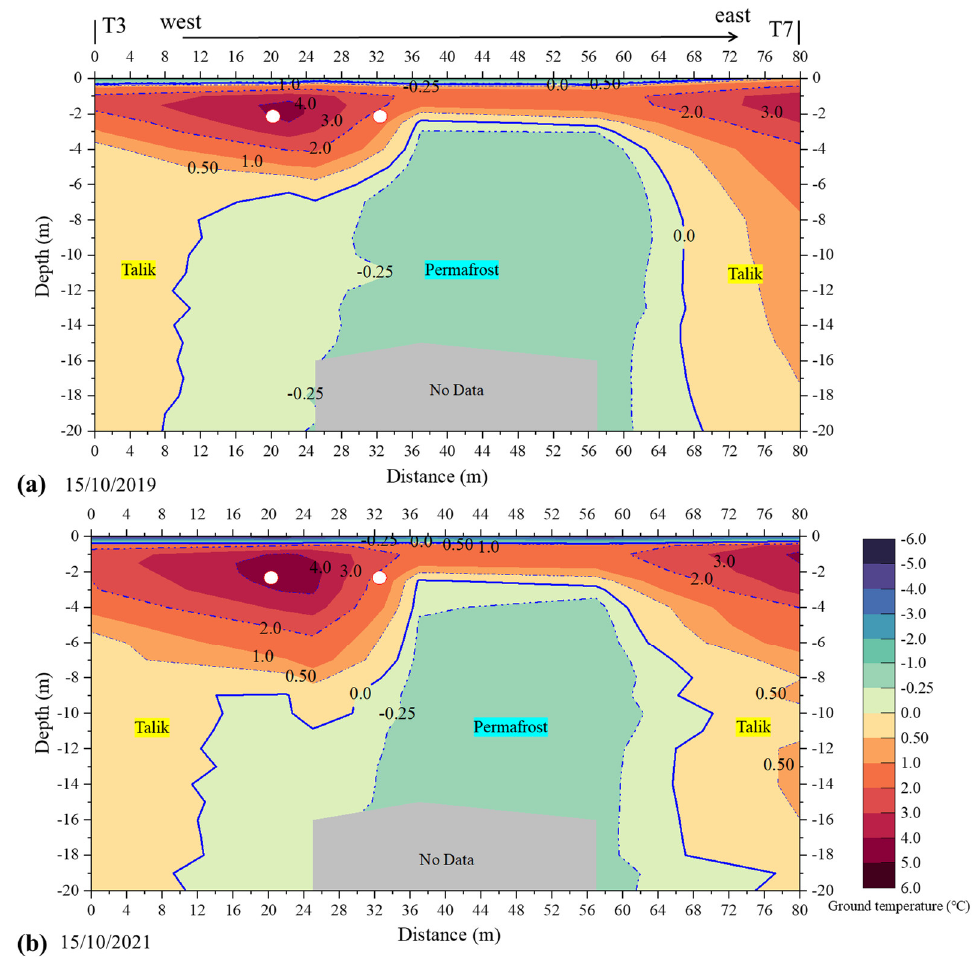
Figure 13. The cross-sectional isotherm profiles of the MDS304 site on 15 October 2019 ( a ) and 15 October 2021 ( b ) were drawn by using the inverse distance weighting method. Note: T3, T7 is a ground temperature borehole. The red circle represents the oil pipeline, and CRCOP-II and CRCOP-I are distributed sequentially from west to east.